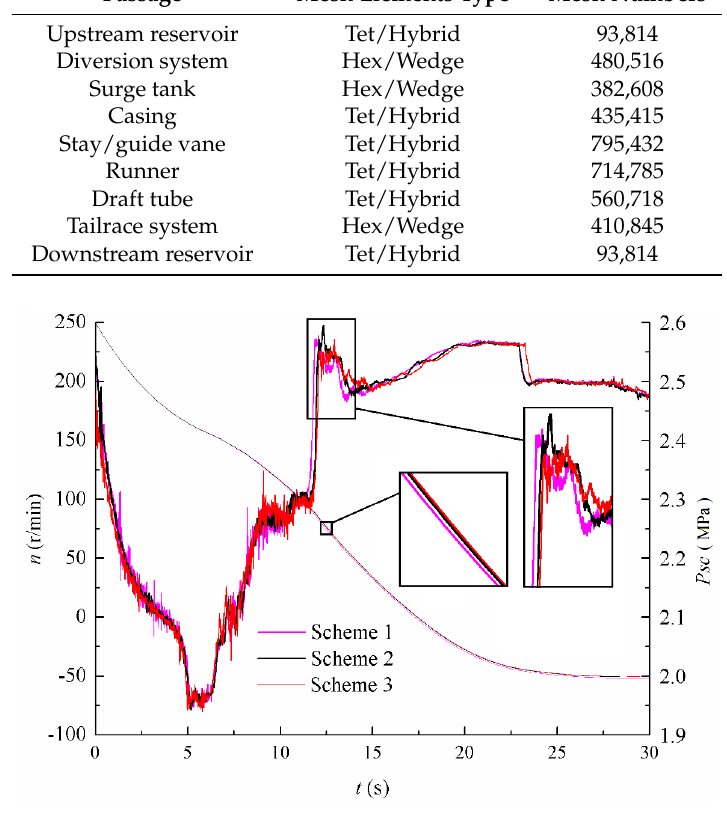
Figure 4. Pre-calculated results of different meshing schemes.